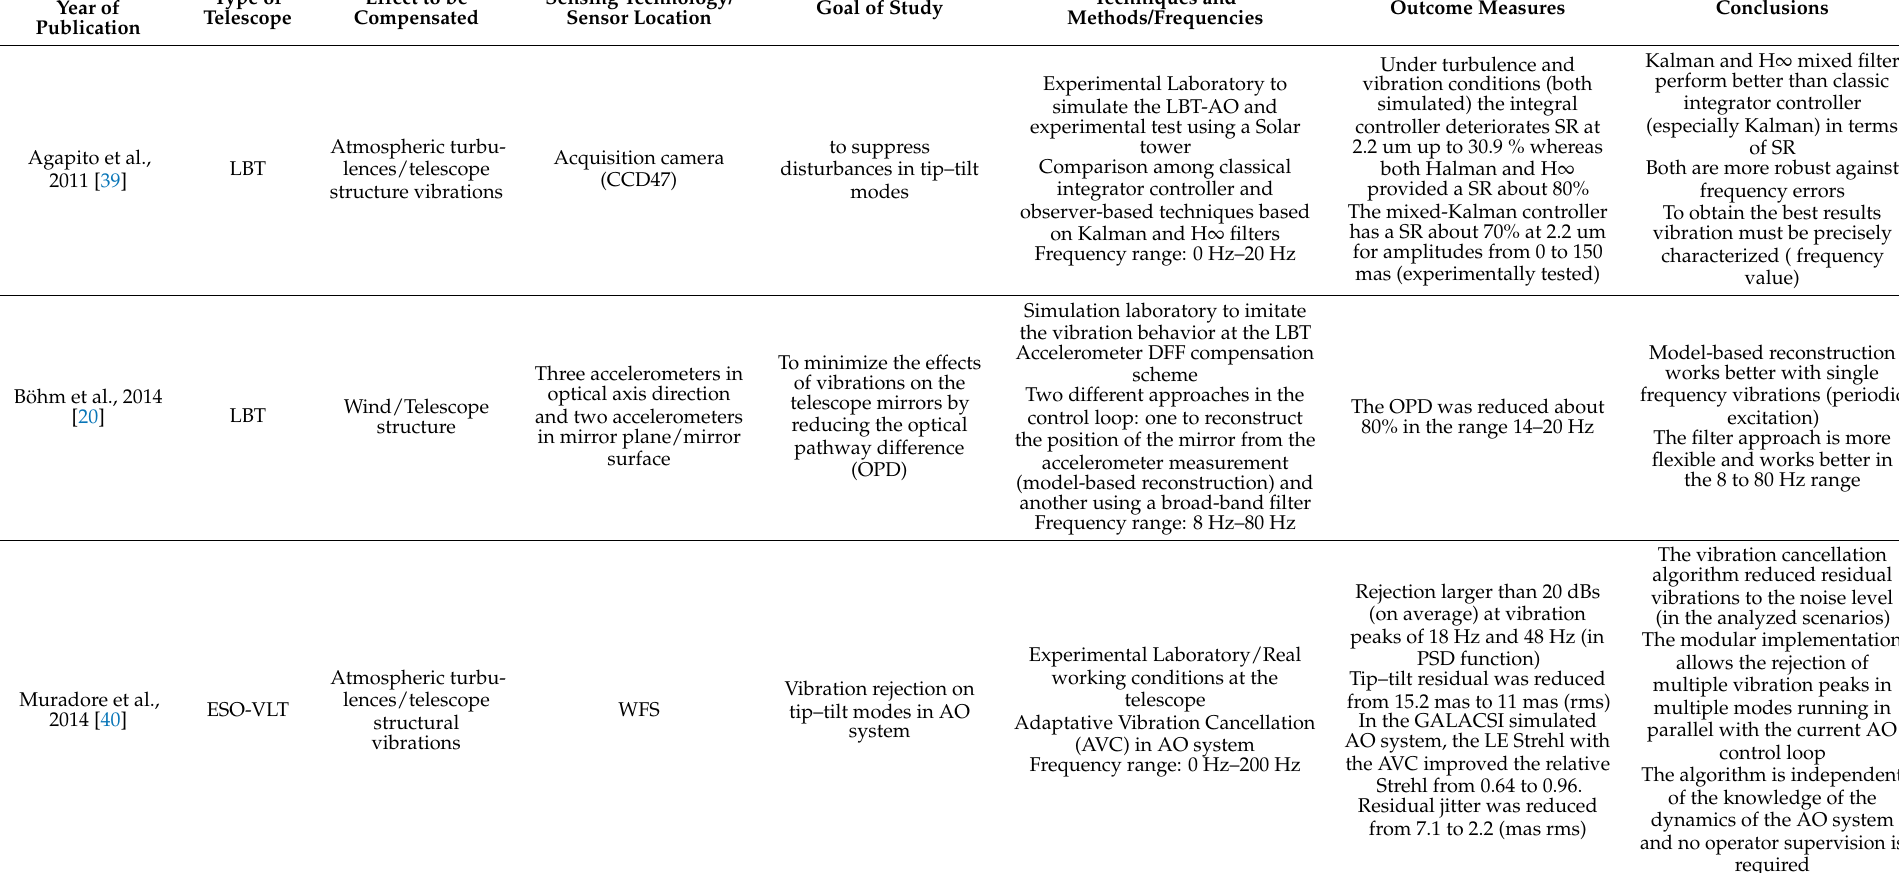
Table 1. Characteristics of the included